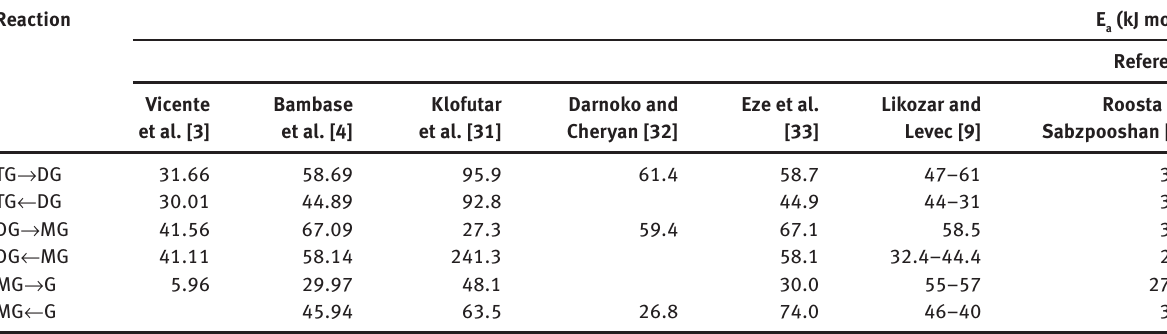
Table 4: The values of E